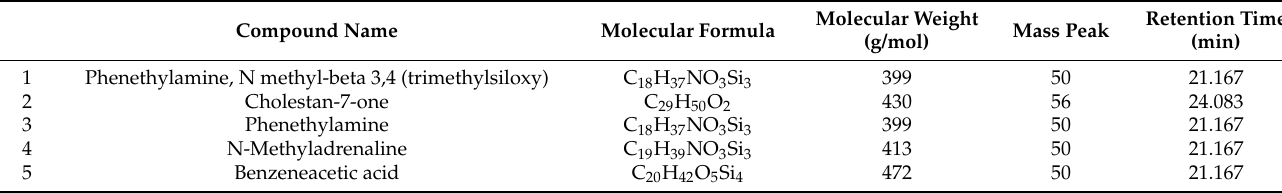
Table 4. Compounds detected in AfL.s by GC–MS.